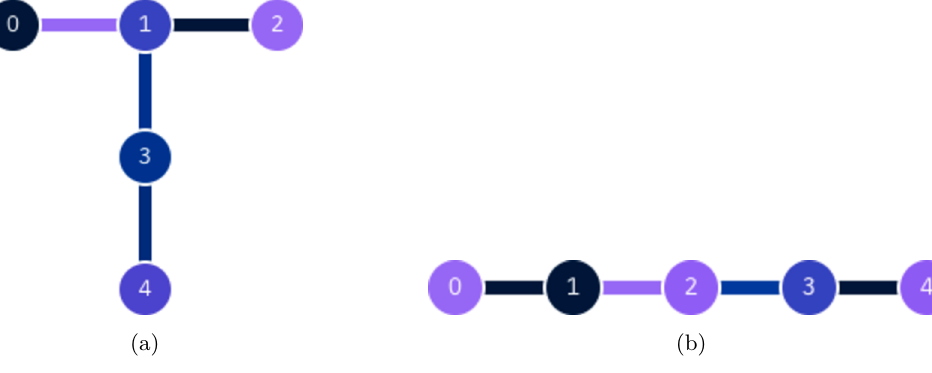
Figure 11. Qubit structure of ibmq-belem (a) and ibmq-santiago (b).